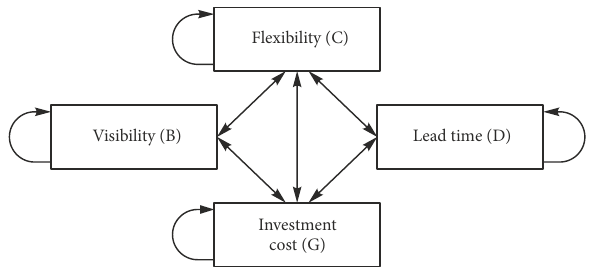
Figure 7. Relationship between dimensions preferred by LSPs